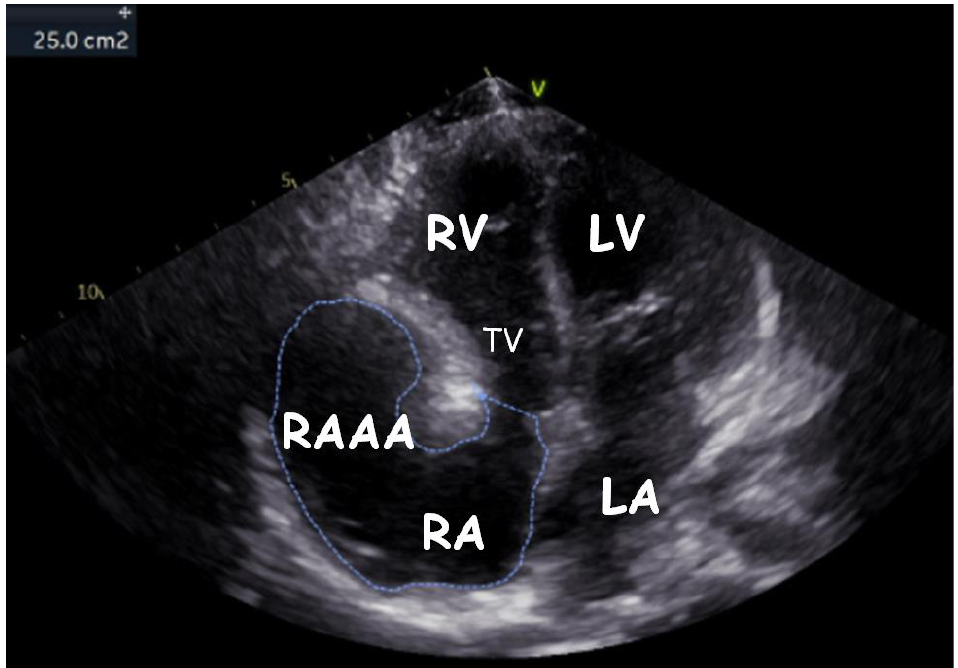
Figure 6. Transthoracic echocardiogram ten years later. Modified subcostal view showing the gigantic RAAA and the RA (estimated surface or RAAA + RA = 25 cm 2 ).